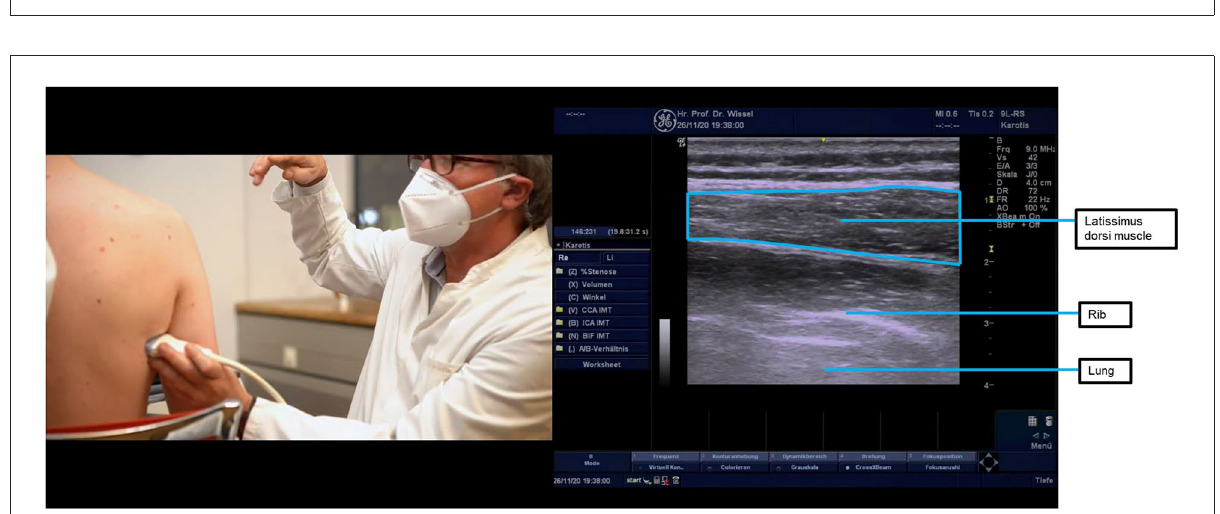
FIGURE4 Ultrasound probe placement and image of the latissimus dorsi muscle. The latissimus dorsi muscle can be located by beginning at the posterior axillary fold and then moving the ultrasound probe down the thorax, about halfway toward the lower thoracic vertebrae. To better distinguish the muscle from the subcutaneous tissue, the probe should be parallel to muscle fiber orientation, thus making its fibrillar pattern apparent. In this anatomical location, the latissimus dorsi will be the most superficial muscle, as shown in the image. Underneath it lies the serratus anterior muscle, also shown in the ultrasound image. Just under the serratus anterior muscle, it is also possible to see one rounder hyperechoic line on the bottom right, which corresponds to a rib, and a more linear hyperechoic line on the bottom left, which corresponds to the pleura. The injection can be performed with the probe either in the longitudinal or transversal orientations, but longitudinal is preferred due to the proximity of the pleura. Multiple injections (two or three) are recommended for the latissimus dorsi due to the size and strength of the